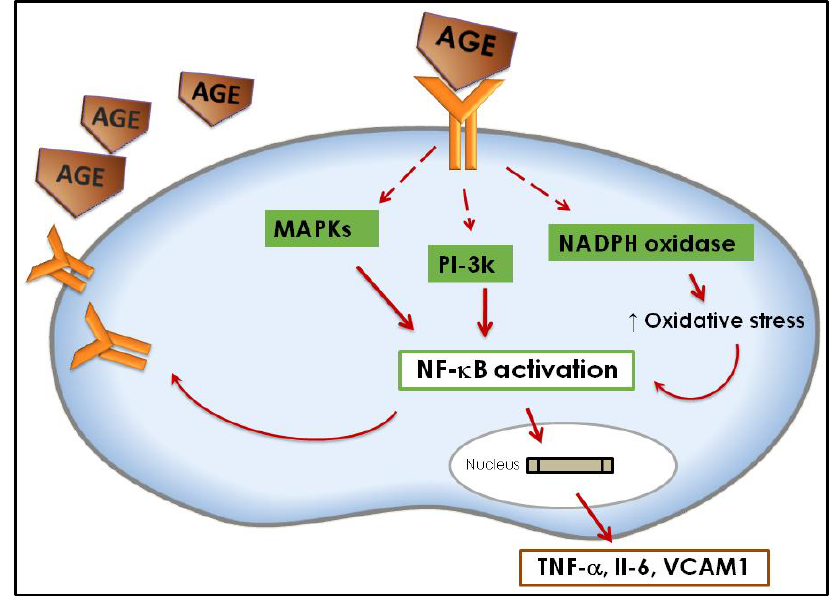
Figure 2. Mechanism of AGEs action at the cell